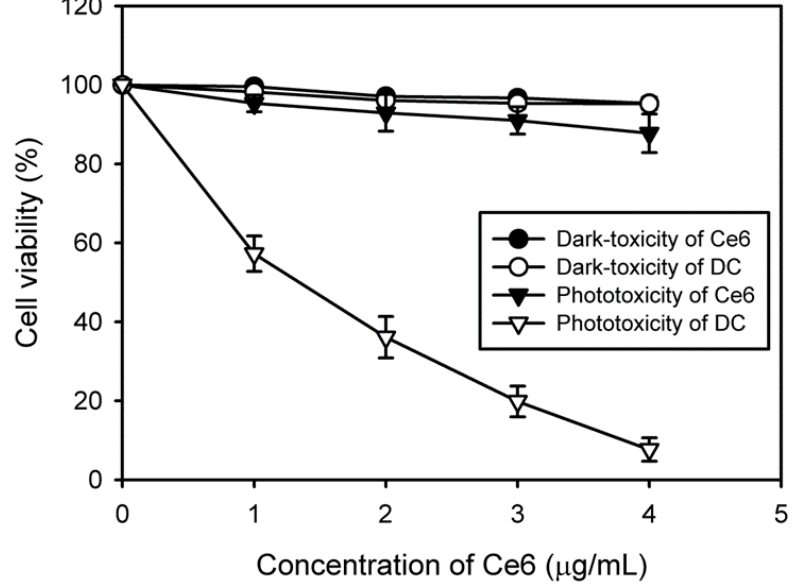
Figure 7. In vitro phototoxicity and dark-toxicity of various concentrations of Ce6 and DC on HeLa cells with and without laser irradiation ( n = 6).